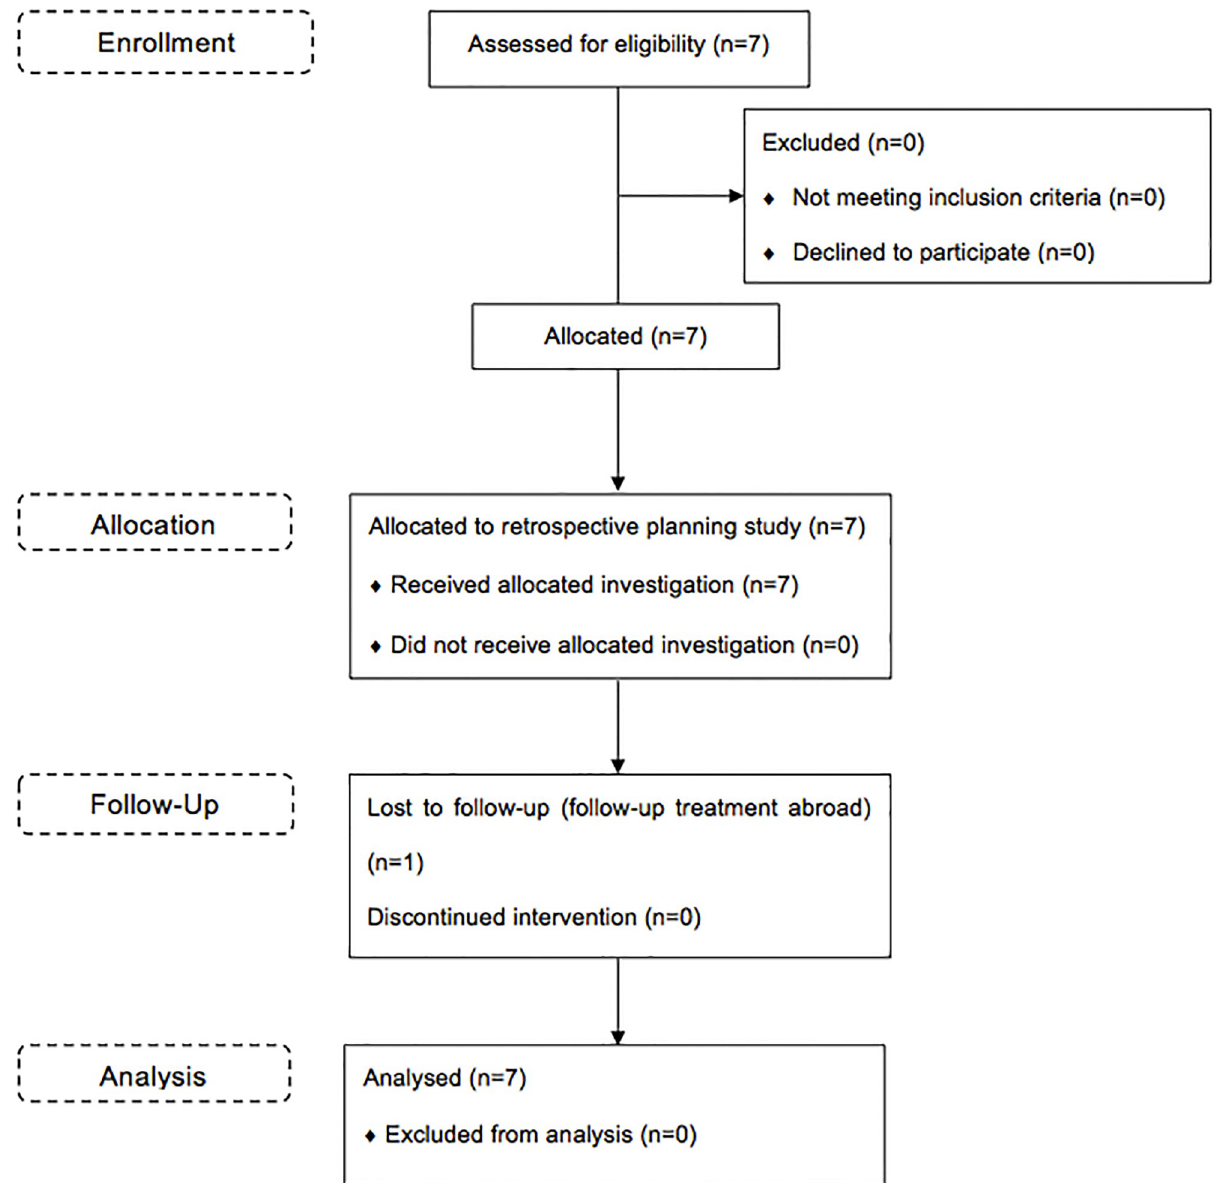
Fig 2. CONSORT flowchart. Flowchart on enrollment, allocation, follow-up and analysis of the retrospective planning study.